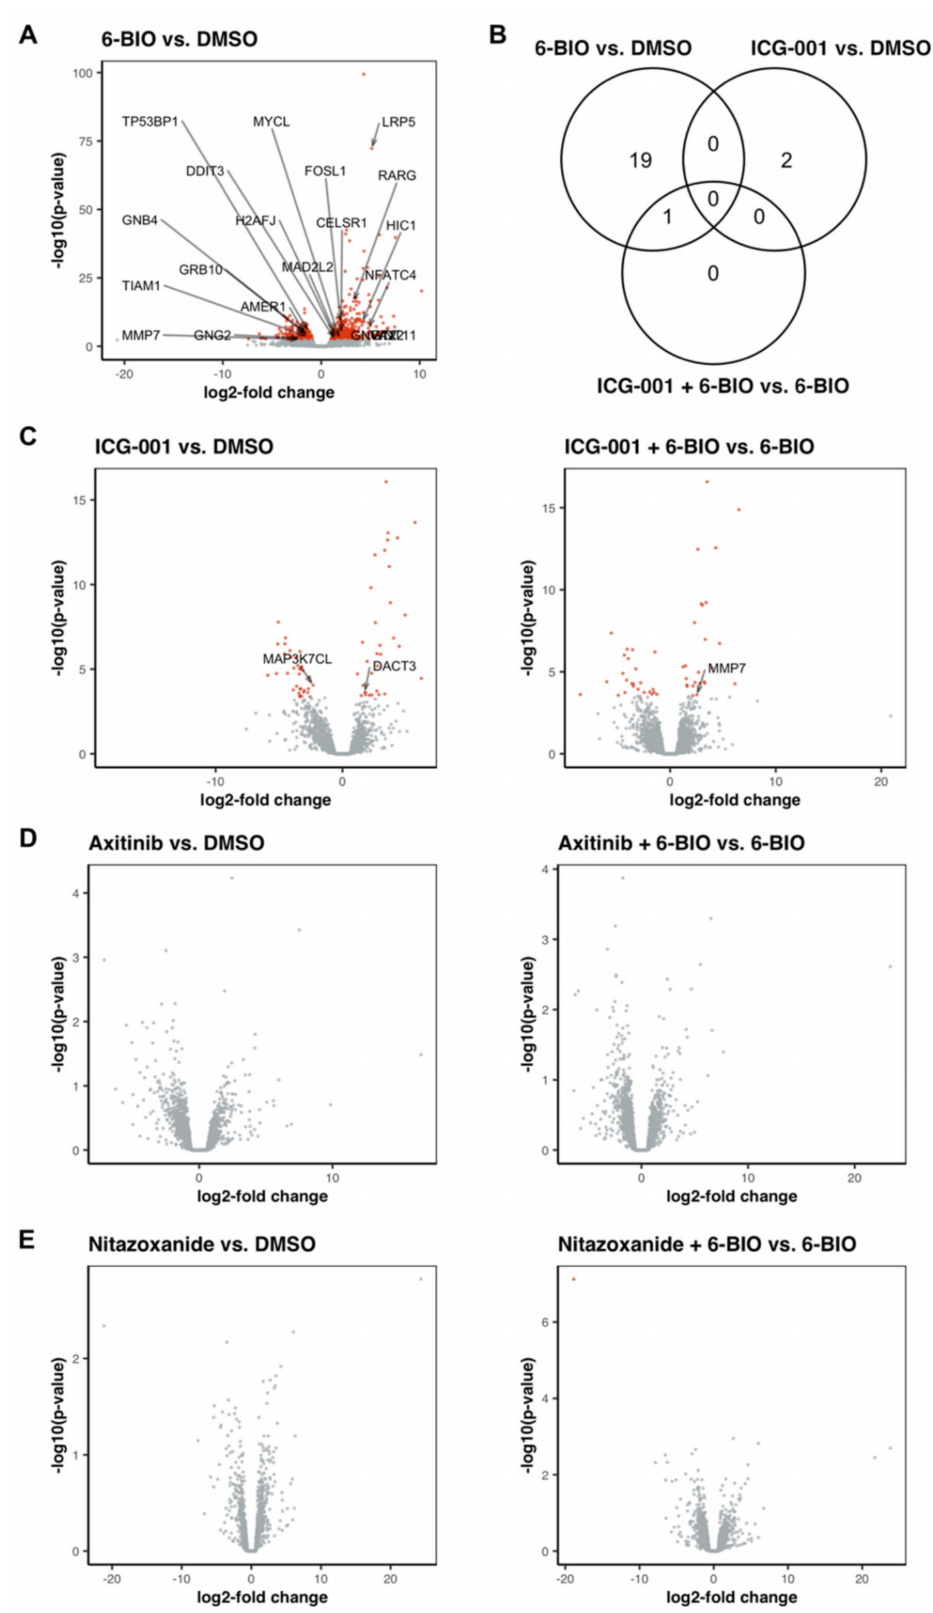
Figure 6. Volcano plots showing the changes in gene expression in LPS-matured dendritic cells (DC) following treatment with 6-BIO, ICG-001, axitinib, and nitazoxanide. Gene counts were acquired by RNA-seq, followed by differential gene expression (DGE) analysis. The x-axis is showing the